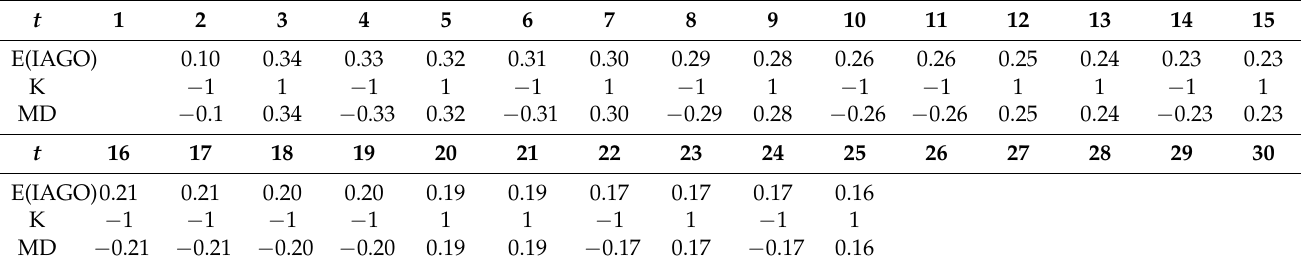
Table 14. The first difference series of displacements reconstructed.